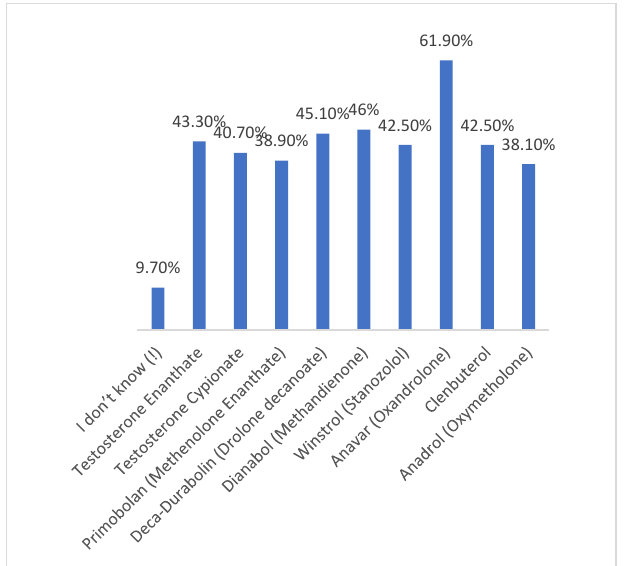
Figure 1. The prevalence of the most commonly used Androgenic – Anabolic Steroids (AAS) brands (generic). Nearly 64.6% of gym members had been consuming AAS for more than 5 years, while 20.4% had been using steroids for three years or more (Figure 2).